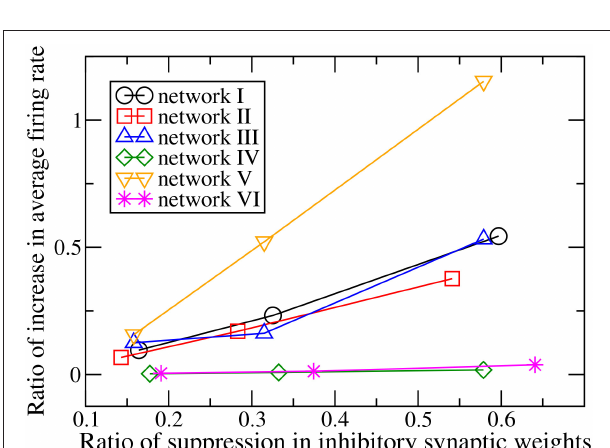
FIGURE 3 | Dependence of the ratio of the increase of the average firing rate of the whole network on the ratio of suppression in inhibitory synaptic weights for the six